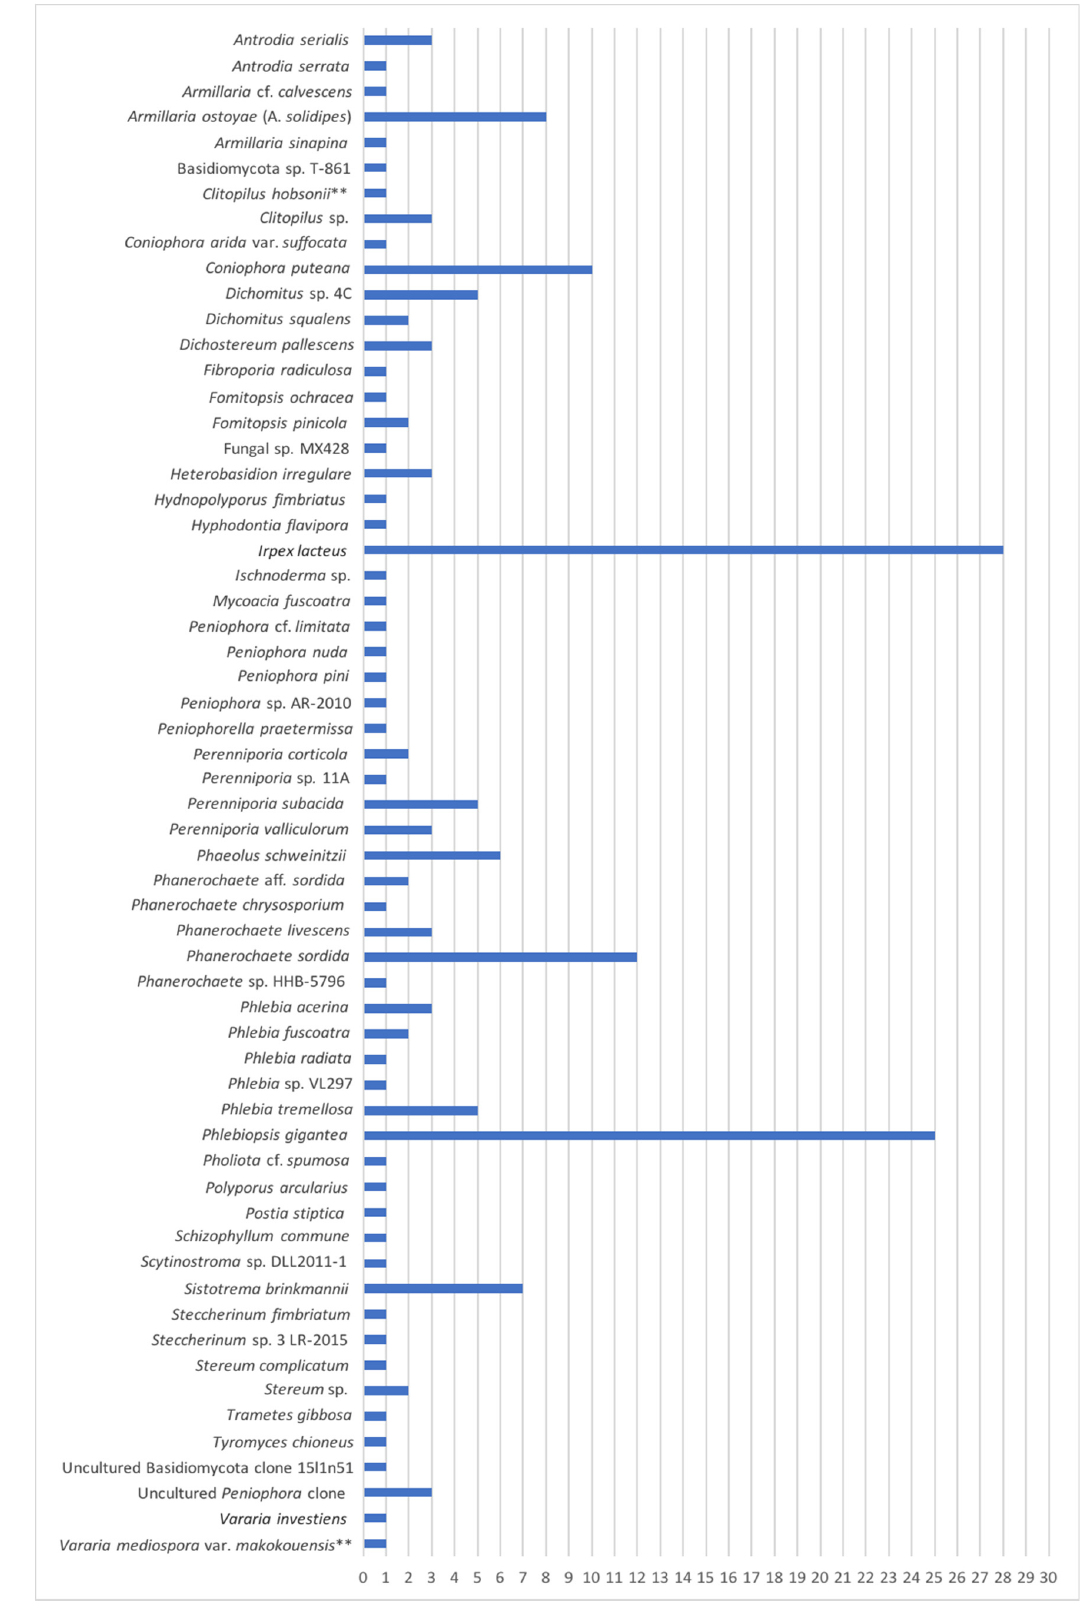
Figure 3. Basidiomycota taxa isolated from different woody substrates and sporophores throughout Minnesota during surveys for H. irregulare . ** following the taxon name indicates that the best blast match was below 97% similarity. Bar represents number of isolates. GenBank accession numbers for taxa are presented in Table S1 of Supplementary Materials.